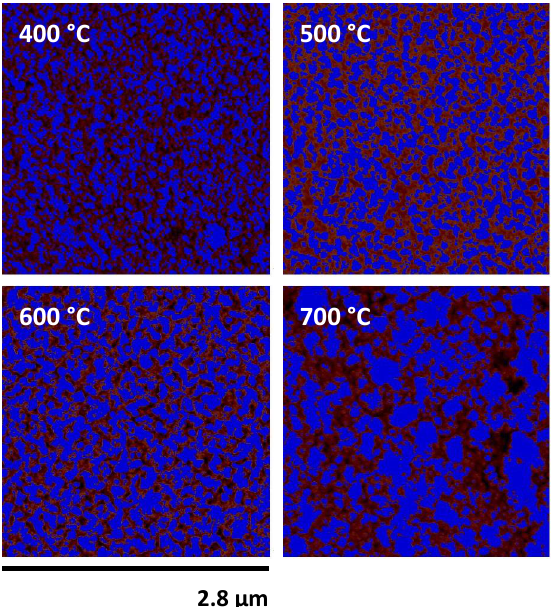
Figure 9. Fibre topography of heat-treated fibres masked to identify the coverage of the structure (sample areas approx. 2.8 × 2.8 µ